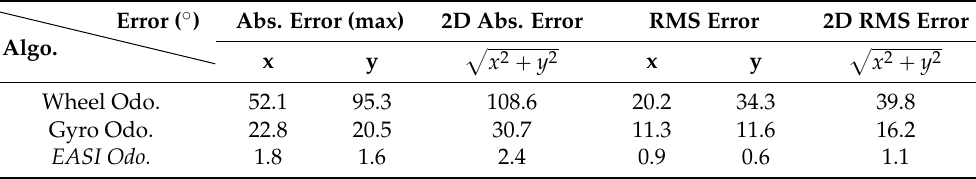
Table 8. Statistical comparison of different localization